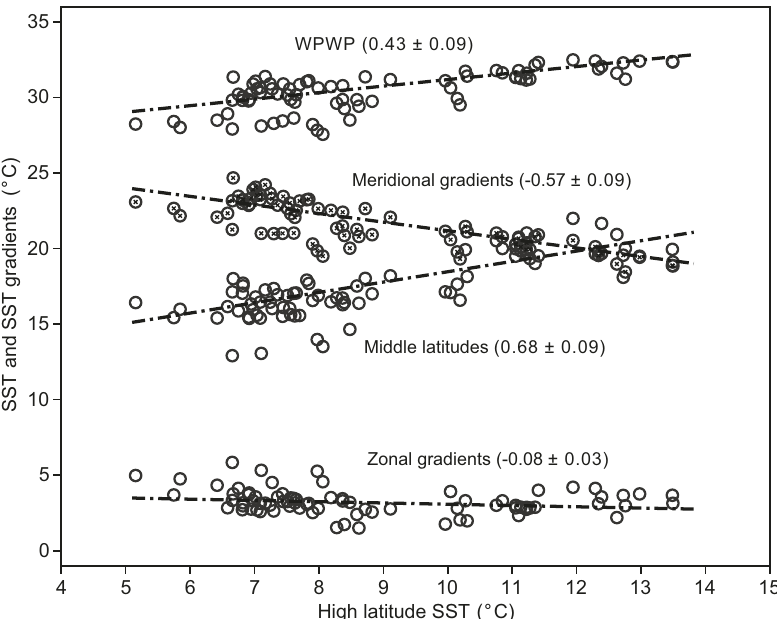
Fig.3|WPWPandmiddlelatitudetemperaturesandmeridionalandequatorial zonal temperature gradients plotted against the corresponding high latitude SSTsoverthelast10Myr. Meridionalgradientsareseasurfacetemperature(SST) differencesbetweentheWesternPaci fi cWarmPool(WPWP)andthehighlatitudes, and zonal gradients are SST differences between the WPWP and the Eastern